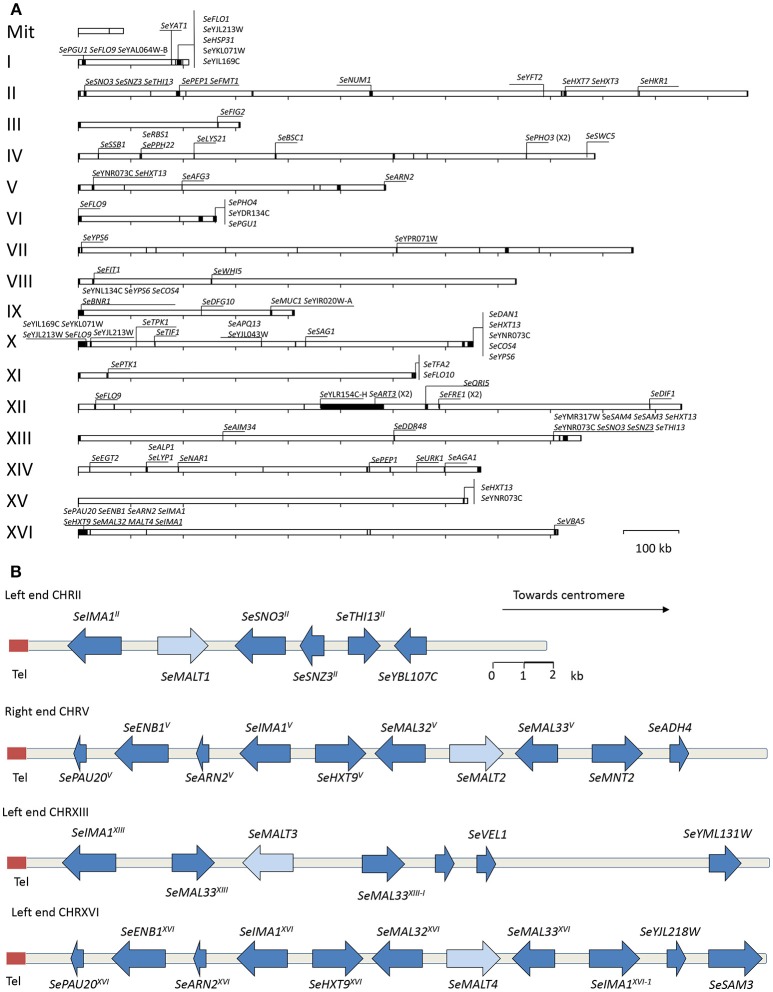
High-quality S. eubayanus CBS12357T genome assembly with 330 kb of unexplored sequence including four MAL loci. (A) Representation of the assembled S. eubayanus chromosomes, the black boxes denote newly added sequences. New annotated open reading frames and gene entries modified relative to the earlier draft genome (Baker et al., 2015) often leading to a redefinition of start and stop codons. (B) Organization of subtelomeric regions including maltose metabolism genes. Arrows denote the direction of transcription. The label “Tel” indicates the position of the telomere. The SeMALT genes are indicated in light blue. The gene and interval sizes are approximately to scale.